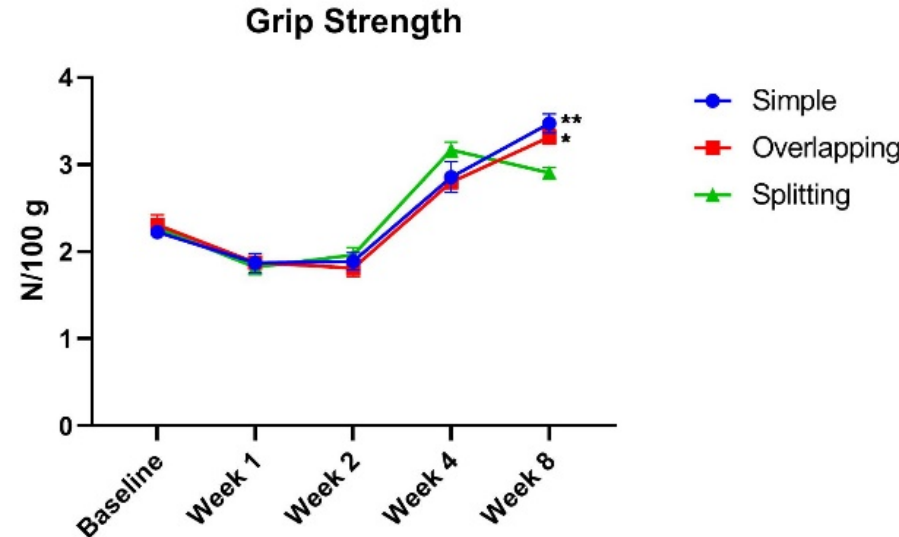
Figure 4. Grip strength test. Although all groups demonstrated the same grip strength at baseline, the simple interrupted suture and overlapping suture groups demonstrated significantly higher muscle power than the splitting suture group at week 8 (simple vs. splitting, ** p = 0.0092; overlapping vs. splitting, * p = 0.0113).